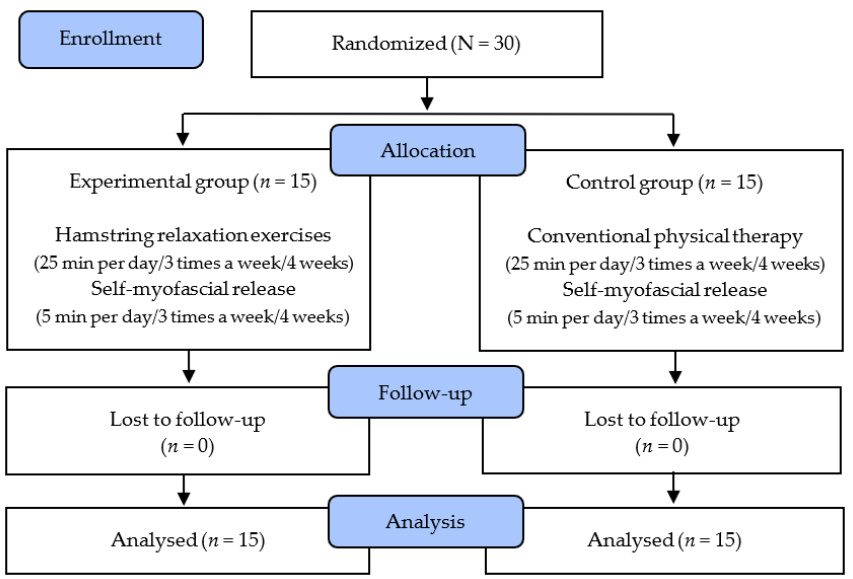
Figure 1. Flow diagram of total experimental